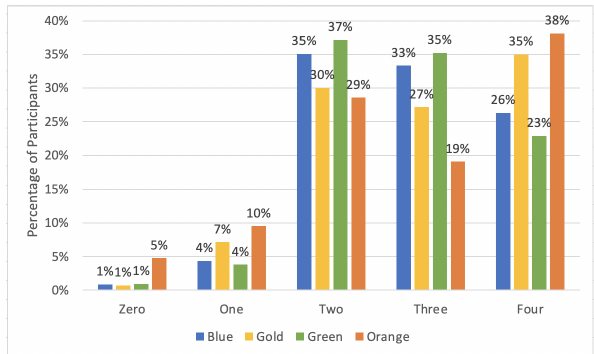
Figure 4. MTurk survey: True Colors personality self-schemas and zxcvbn password scores.